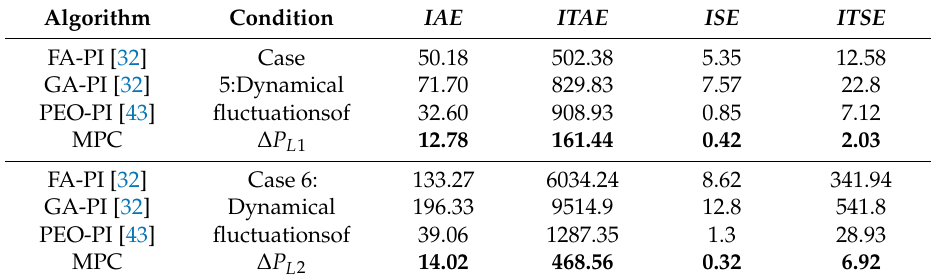
Table 8. Performance comparison of MPC, PEO-PI, GA-PI and FA-PI for dynamical load